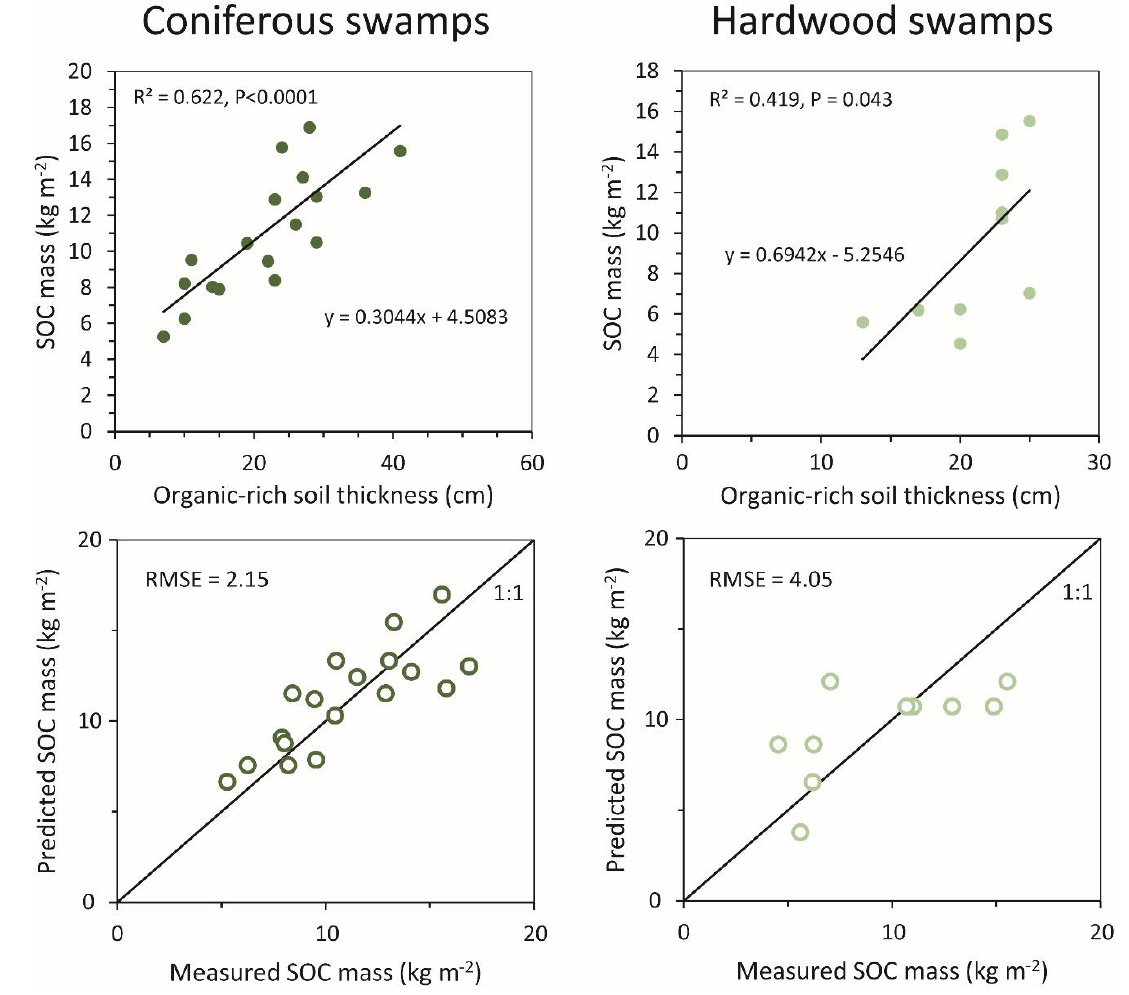
Figure 6. Relationship between the organic-rich soil layer thickness and the SOC mass (upper panel) and measured against predicted SOC mass values for coniferous swamps and hardwood swamps (lower panels).